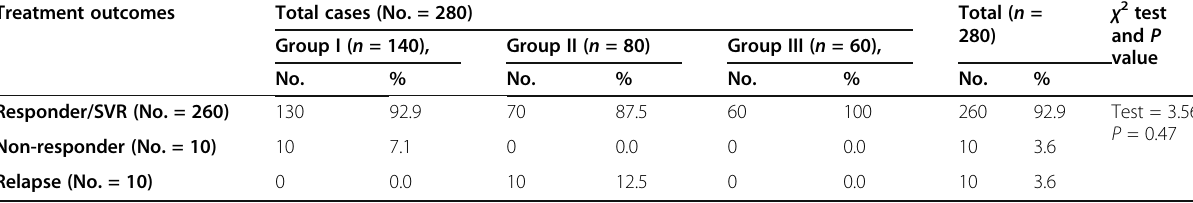
Table 5 Treatment outcomes among the studied groups according to RT-PCR results Treatment outcomes